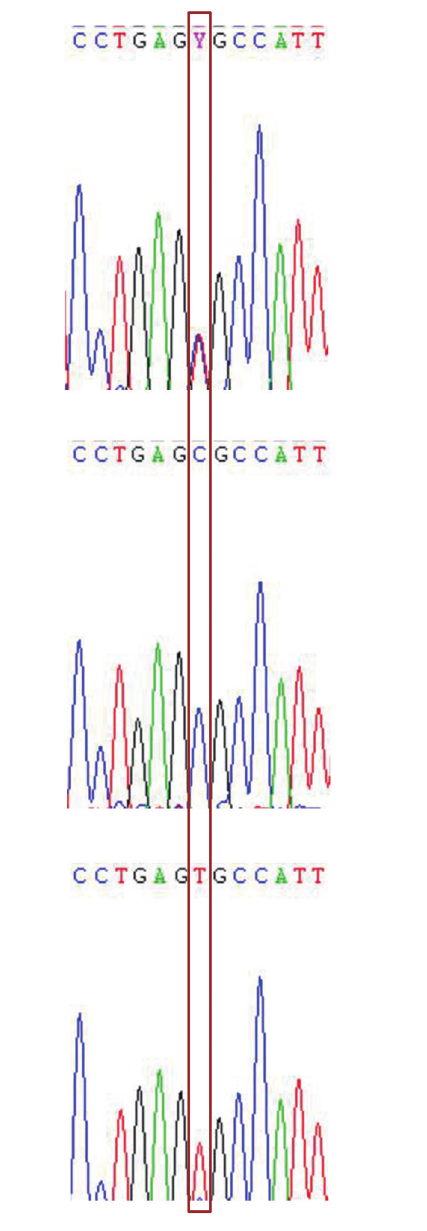
Figure 1. The C/T transition at base position 108 in the exon of MTNR1C gene. The box shows the single nucleotide polymorphism location. MTNR1C, melatonin